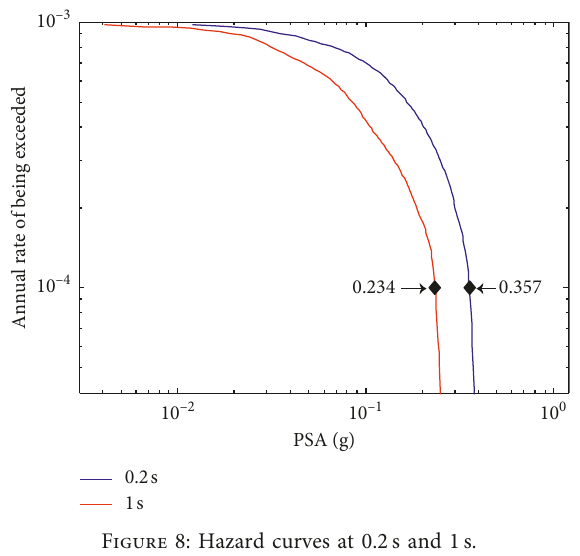
Figure 8: Hazard curves at 0.2s and 1s.